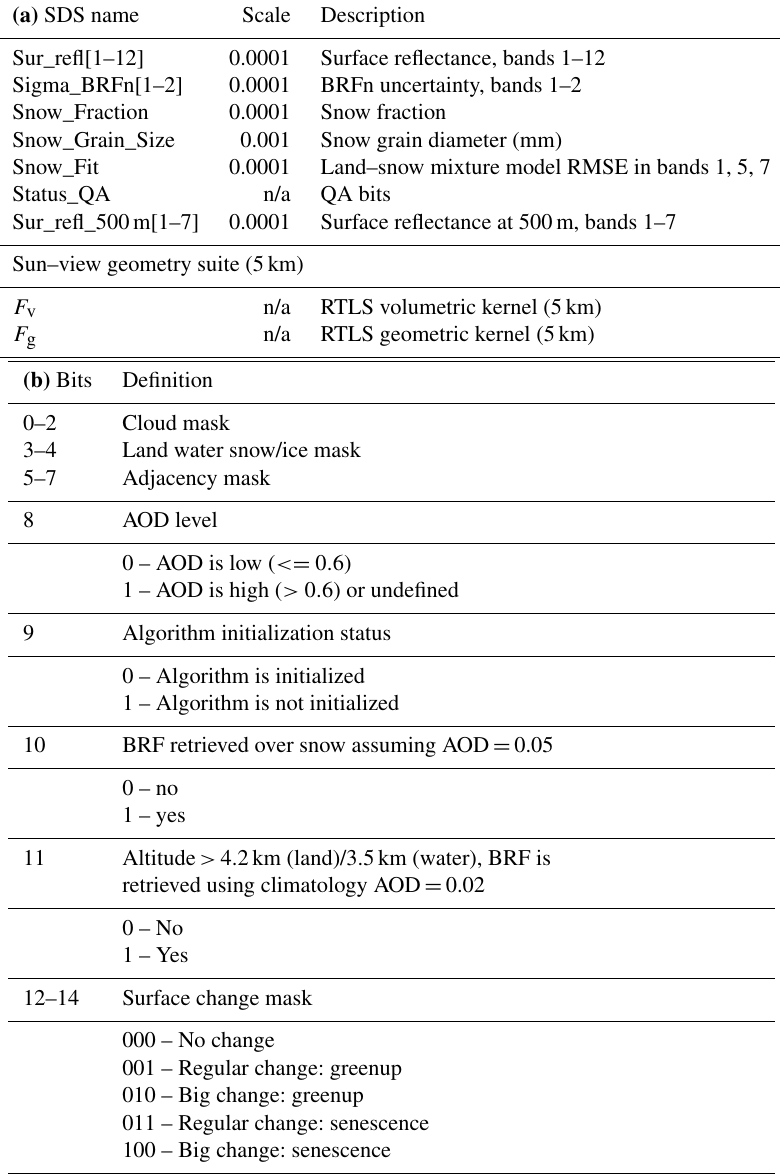
Table 3. (a) Reported parameters in the surface reflectance file (MCD19A1). (b) Surface reflectance QA definition for MCD19A2 (16bit unsigned